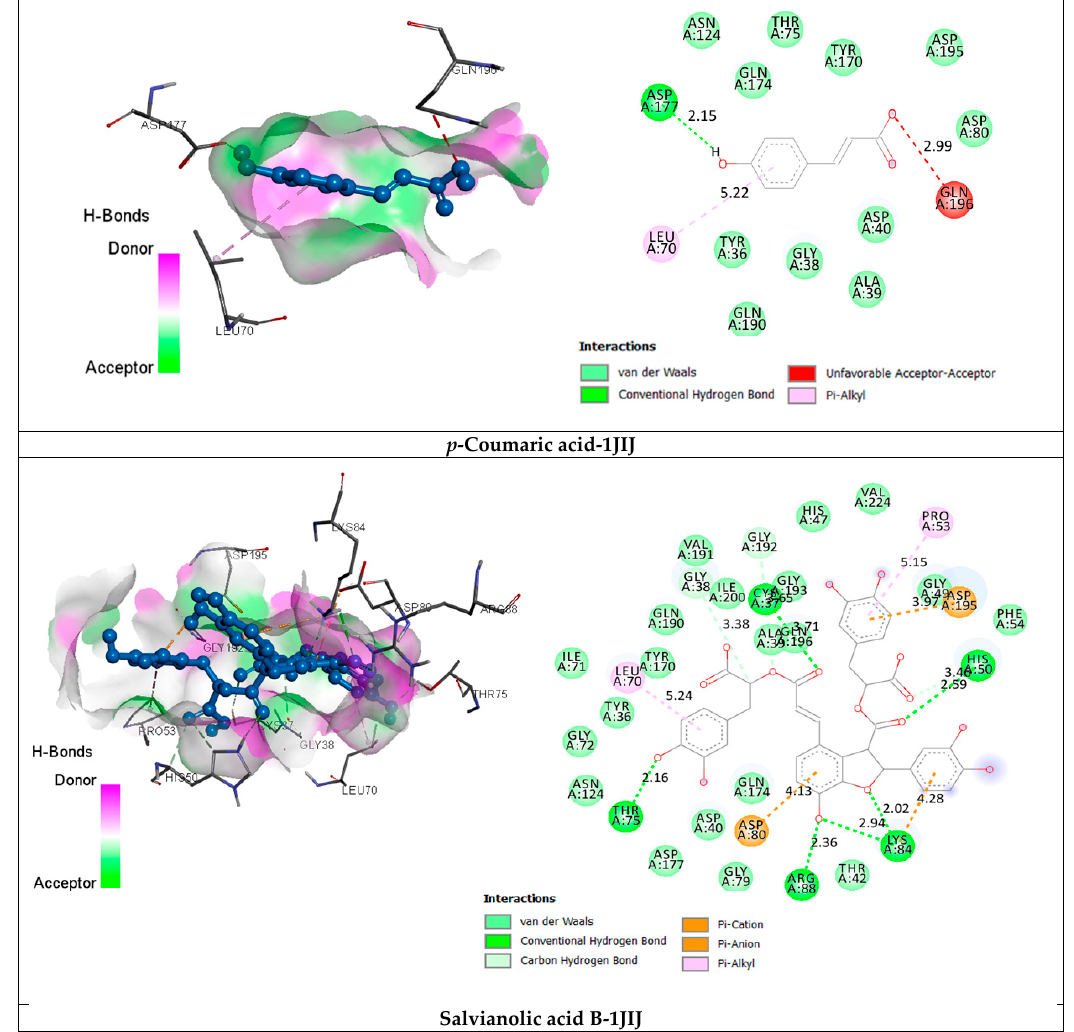
Figure 2. Interactions of tyrosyl-tRNA synthetase TyrRS from S. aureus (PDB: 1JIJ ) with the selected major phytochemicals, with the top two having the lowest binding energies of E. humile methanolic extract.